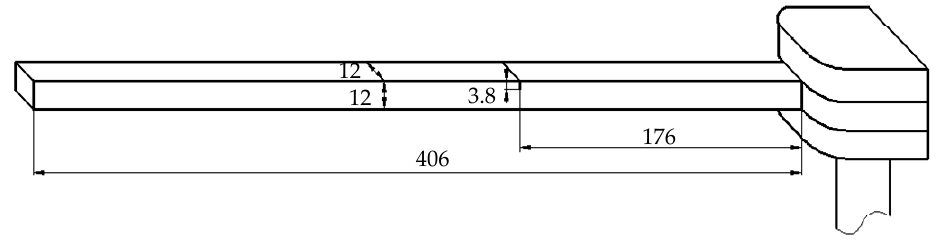
Figure 8. The dimensions of the experimental cantilever beam.